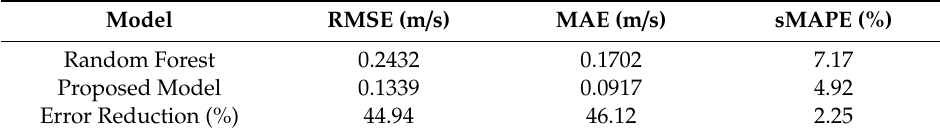
Table 5. Comparison of baseline model with proposed